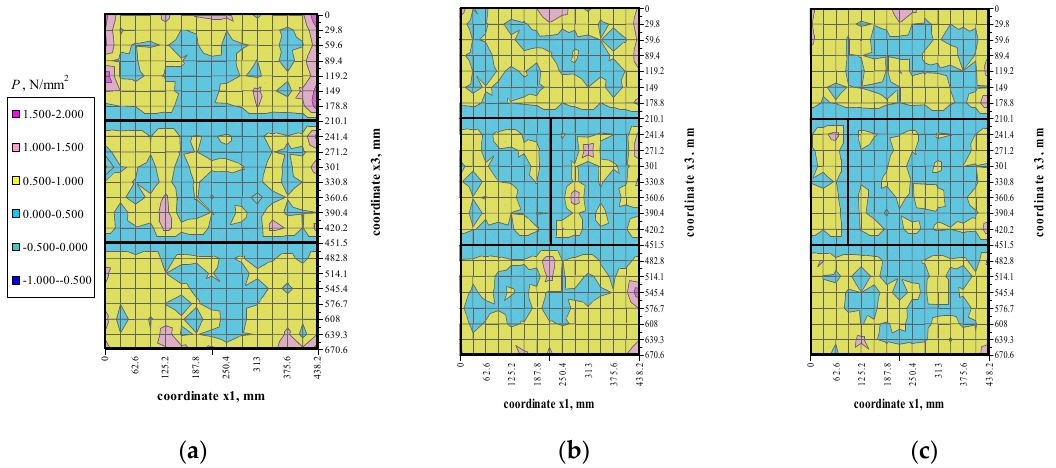
Figure 16. Mean hydrostatic stress values P at load σ 3 = 0.75 σ 3max : ( a ) model I-1, ( b ) model II-1, ( c ) model III-1. The distribution of mean hydrostatic stresses P in all the test models indicated the predominating compression ( P > 0) in the masonry units. Mean hydrostatic stresses were clearly decreasing in some areas adjacent to the head joints. Only at some individual points did mean hydrostatic stress represent tension ( P < 0).